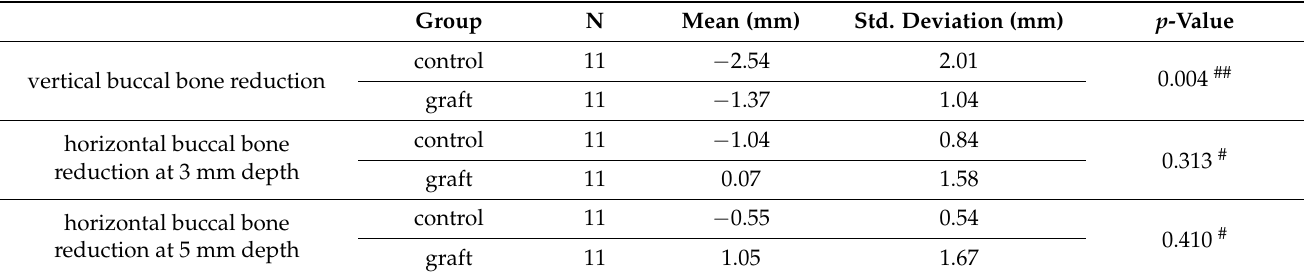
Table 3. Alveolar ridge dimension changes at 1-year follow-up. Abbreviations: One-way ANOVA test ( # ), independent- samples Mann-Whitney-U test ( ## ).